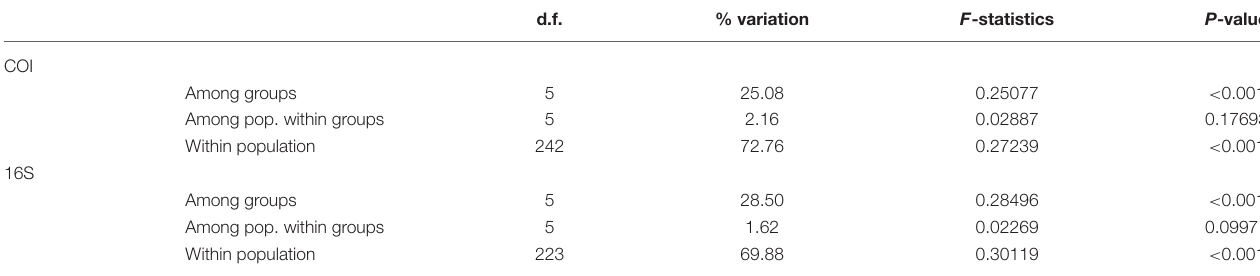
TABLE 3 | AMOVA analysis of sequences of H . atra with multiple different